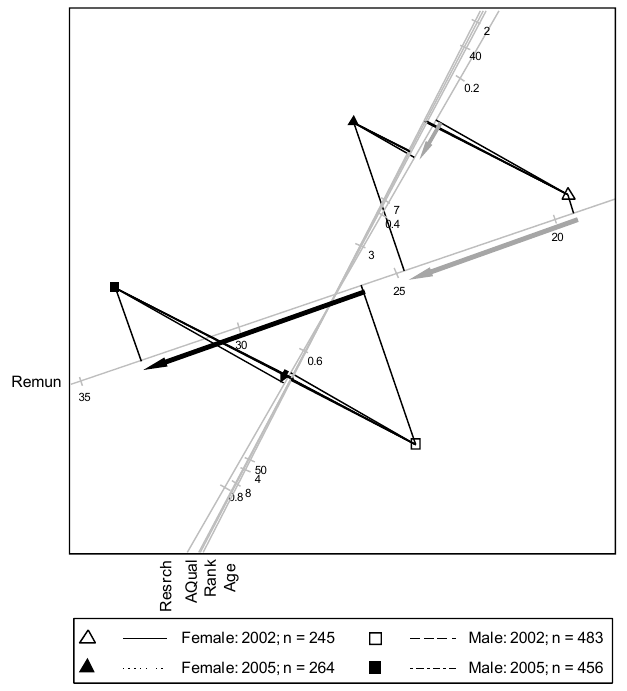
Figure 2: Large-scale CVA biplot showing the means of the 2002 Female, 2005 Female, 2002 Male and 2005 Male subgroups of the complete C1 data set. Also shown are perpendicular lines from each group mean to the five axes showing the biplot predictions of the different variables. The long grey and the long black arrows indicate the changes from 2002 to 2005 in the remuneration for the female and male staff members respectively. Similarly, the short grey and the short black arrows indicate the corresponding changes in the research output. corresponding changes in the case of the females are not only larger, but constitute shifts toward the mean values of their male